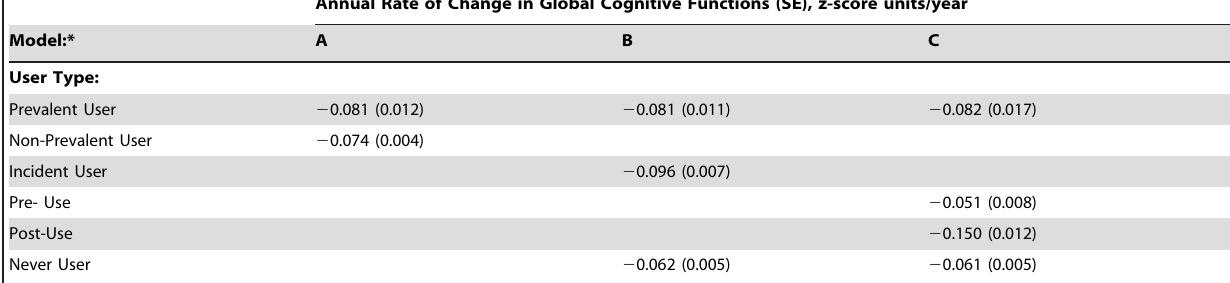
Annual Rate of Change in Global Cognitive Functions (SE), z-score units/year Model:* A